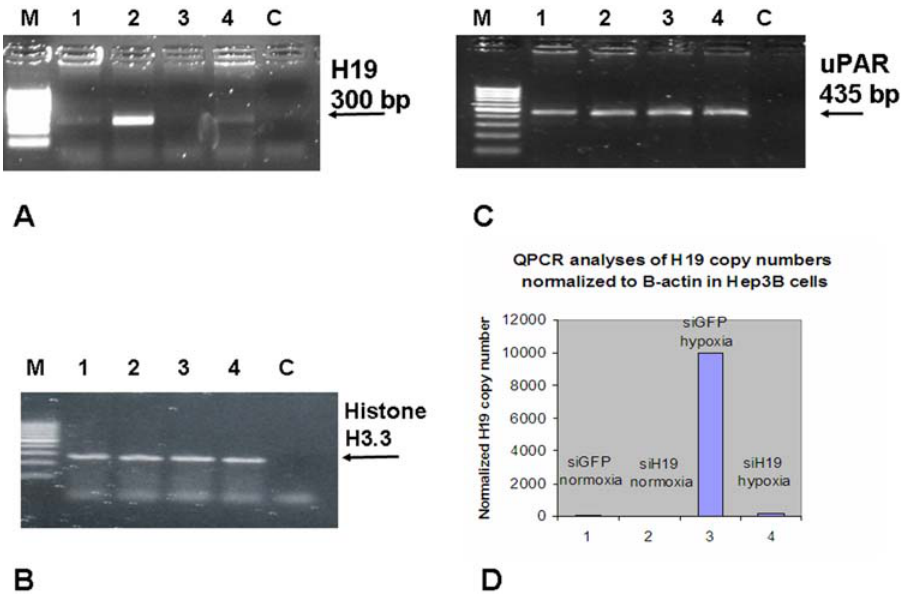
Figure 3. H19 RNA is induced by hypoxic stress in Hep3B cell line and siRNA directed against H19 very efficiently impedes its induction. Hep3B cells were seeded and transfected either with H19 siRNA or luc siRNA . Twenty four hours post transfection, cells were either placed into an aneoropack rectangular jar , or left under normal oxygen concentration. Incubation lasted for 24 hours before RNA extraction. Shown are RT-PCR analyses for H19 RNA (28 PCR cycles). (A): Hep3B transfected with Luc siRNA (lanes 1, 2) and H19 siRNA (lanes 3, 4) both in normal (lanes 1, 3) and hypoxic (lanes 2, 4) culture conditions, respectively. PCR analysis of a house-keeping gene Histone H3.3 (B), and uPAR (C). In (D) QPCR analysis for H19 RNA levels normalized to b -actin in Hep3B cells is depicted.. A Quantitative SYBR Green RT–PCR was performed on human total RNA for both H19 and